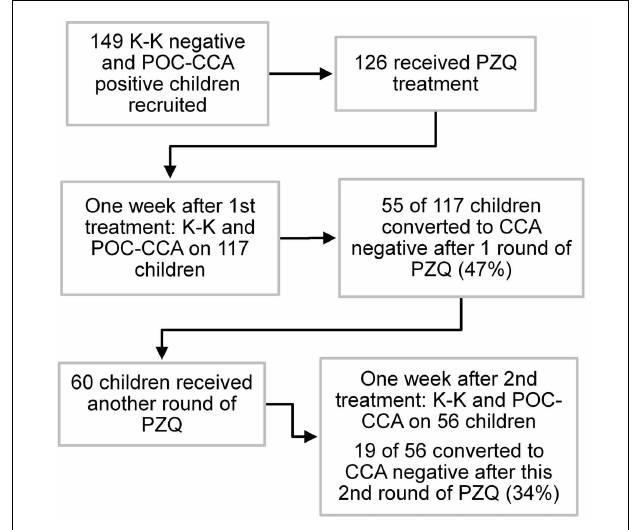
FIGURE 1 | Flow diagram of post-praziquantel treatment study, Kenya